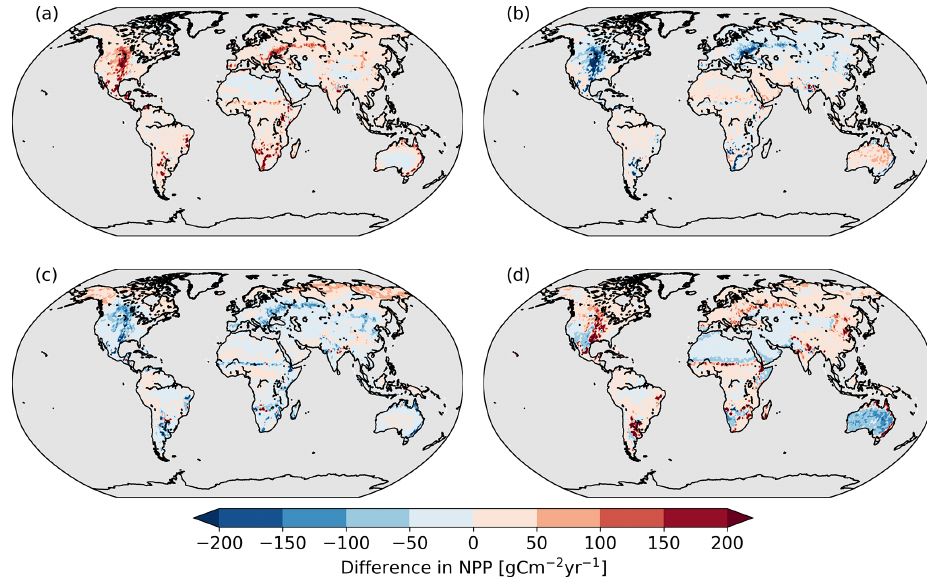
Figure 5. Difference in NPP for (a) Noextremes trees, (b) Noextremes grasses, (c) Hotdry trees, and (d) Hotdry grasses compared to the Control scenario.